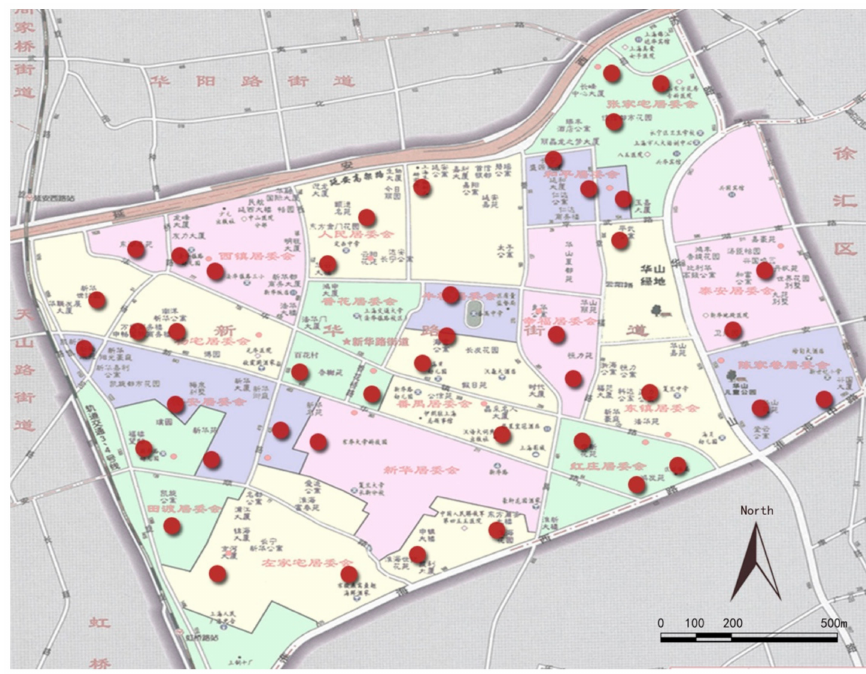
Figure 2. Map of the neighborhood